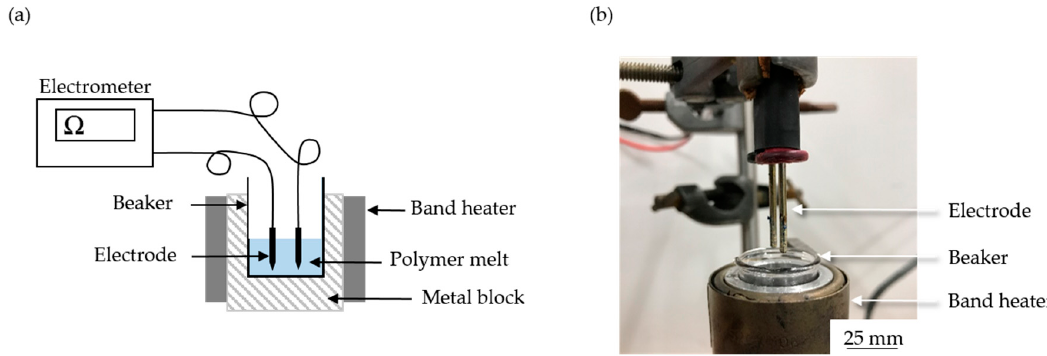
Figure 2. Schematic illustration ( a ) and picture ( b ) of our electrometer setup.